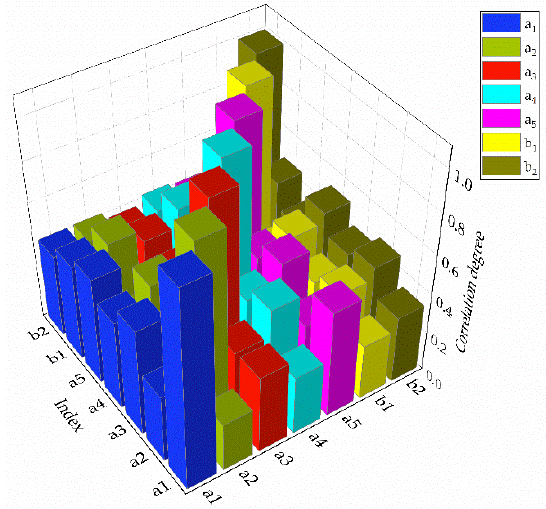
Figure 3. Factor data characteristics.